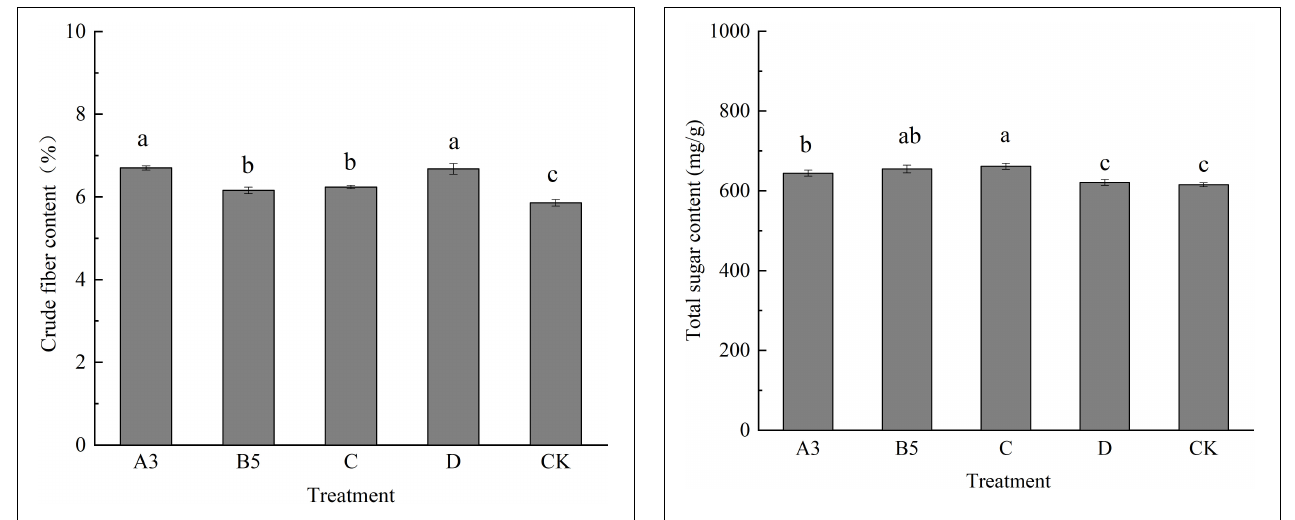
FIGURE 6 | Total sugar content of fruiting bodies of each treatment. Different letters in the figure indicate significant differences ( P < 0.05).